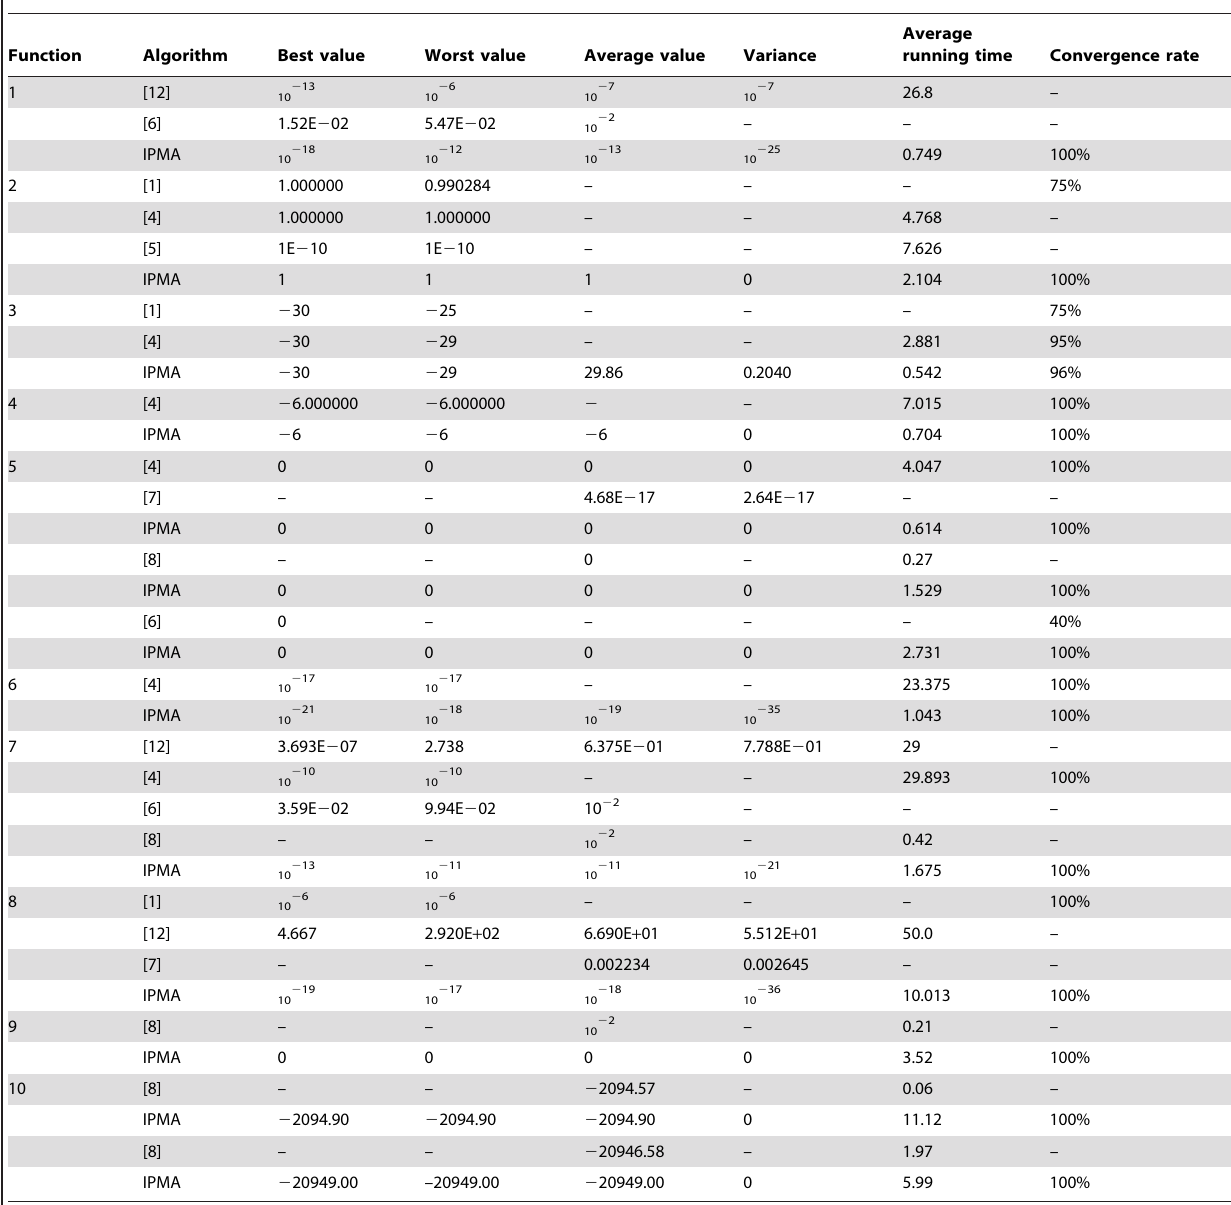
Table 2. Comparison performance of the IPMA in the ten functions.